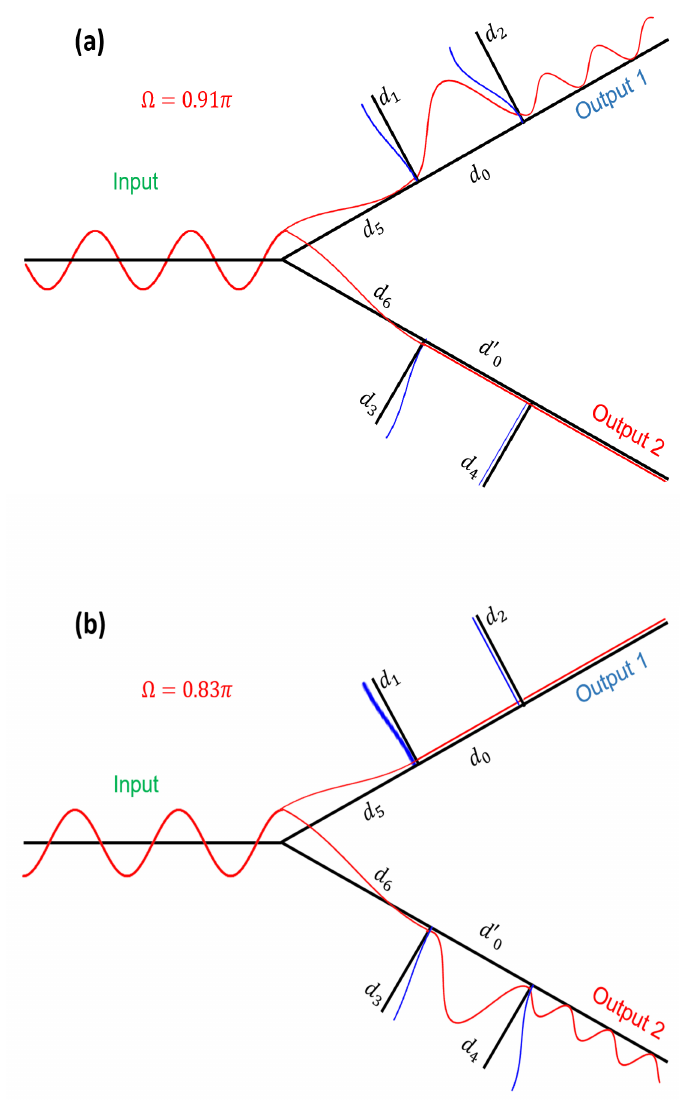
Figure 4. Square modulus of the electric field | E | 2 (in arbitrary units) along the two outputs of the demultiplexer at ( a ) Ω = 0.91 π and ( b ) Ω = 0.83 π for the two Fano resonances discussed in Figure